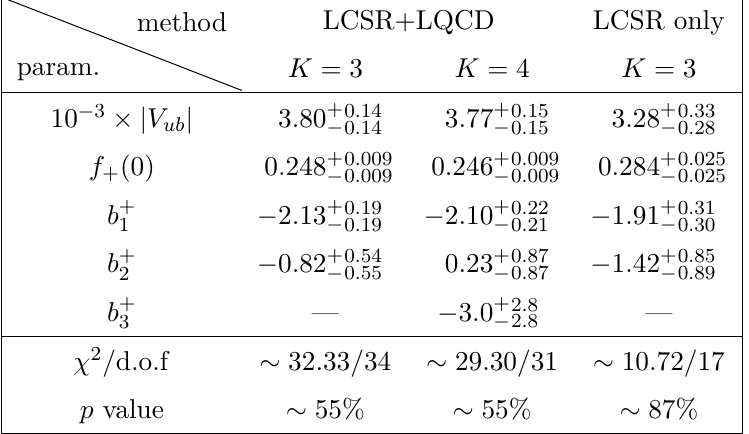
Table 7 . Results from the three fits to combinations of fit models and data sets as described in the text. We provide the median values and central intervals at 68% probability for the one-dimensional marginalized posterior